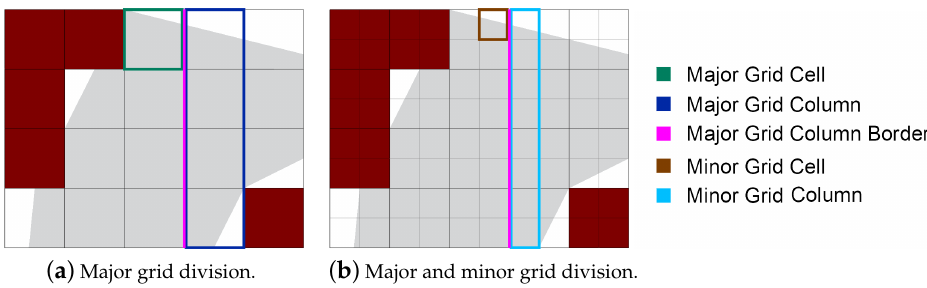
Figure 4. Grid-based area decomposition before and after subdivision.